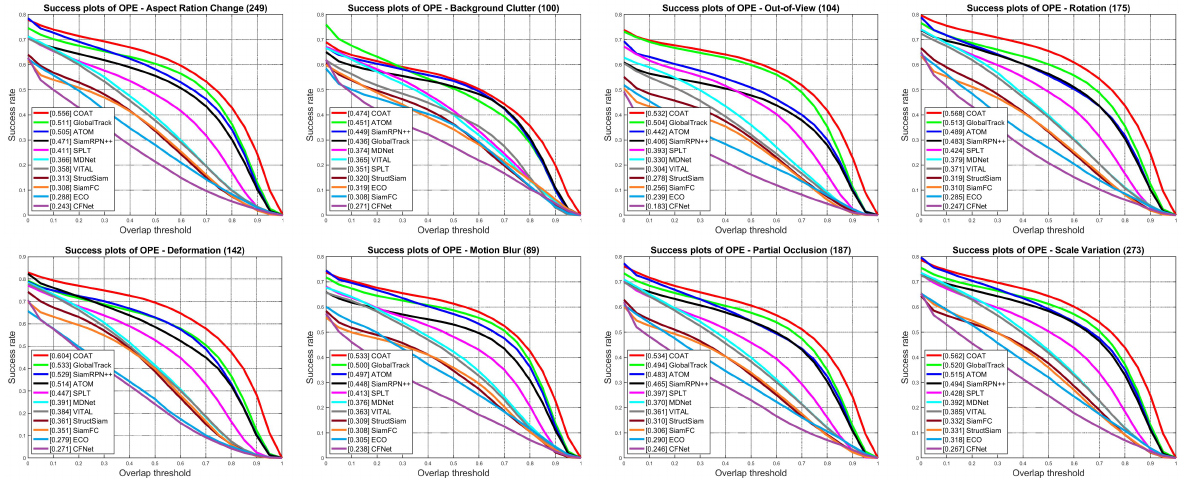
Figure 5. Success plots for eight challenge attributes of LaSOT test set. Best viewed on high- resolution display.